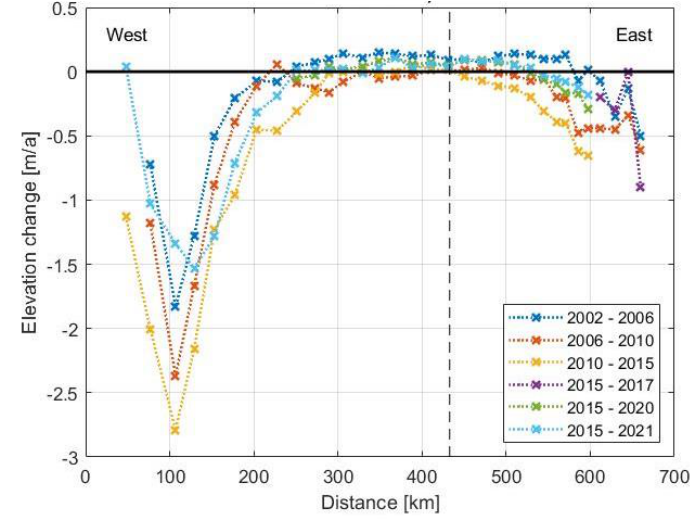
Figure 5. Annual elevation changes in the camps from 2002.